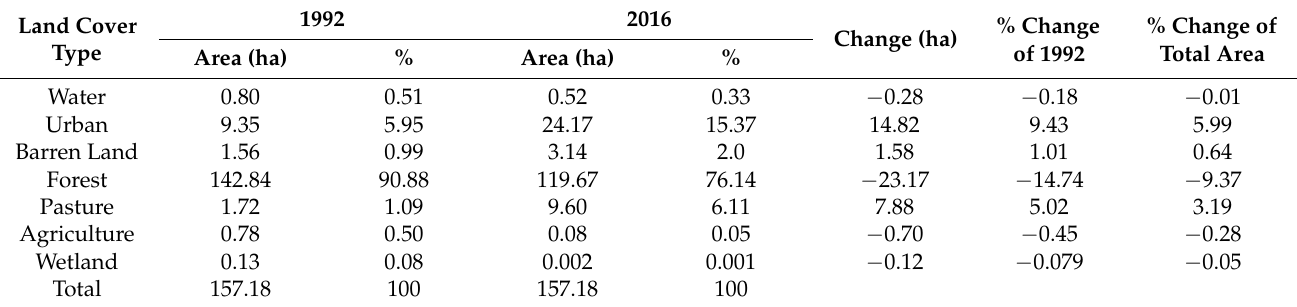
Figure 8. Total annual sediment yield distribution among 21 sub-basins in the Yellow Creek Watershed. Table 5. LULC change from 1992 to 2016 in Yellow Creek